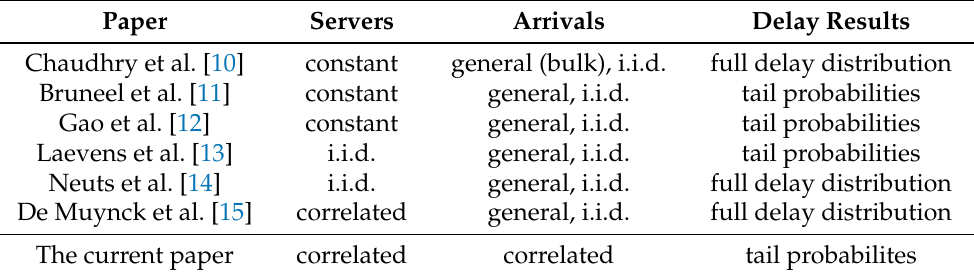
Table 1. Brief summary of the setting and delay results of relevant papers in comparison with the current